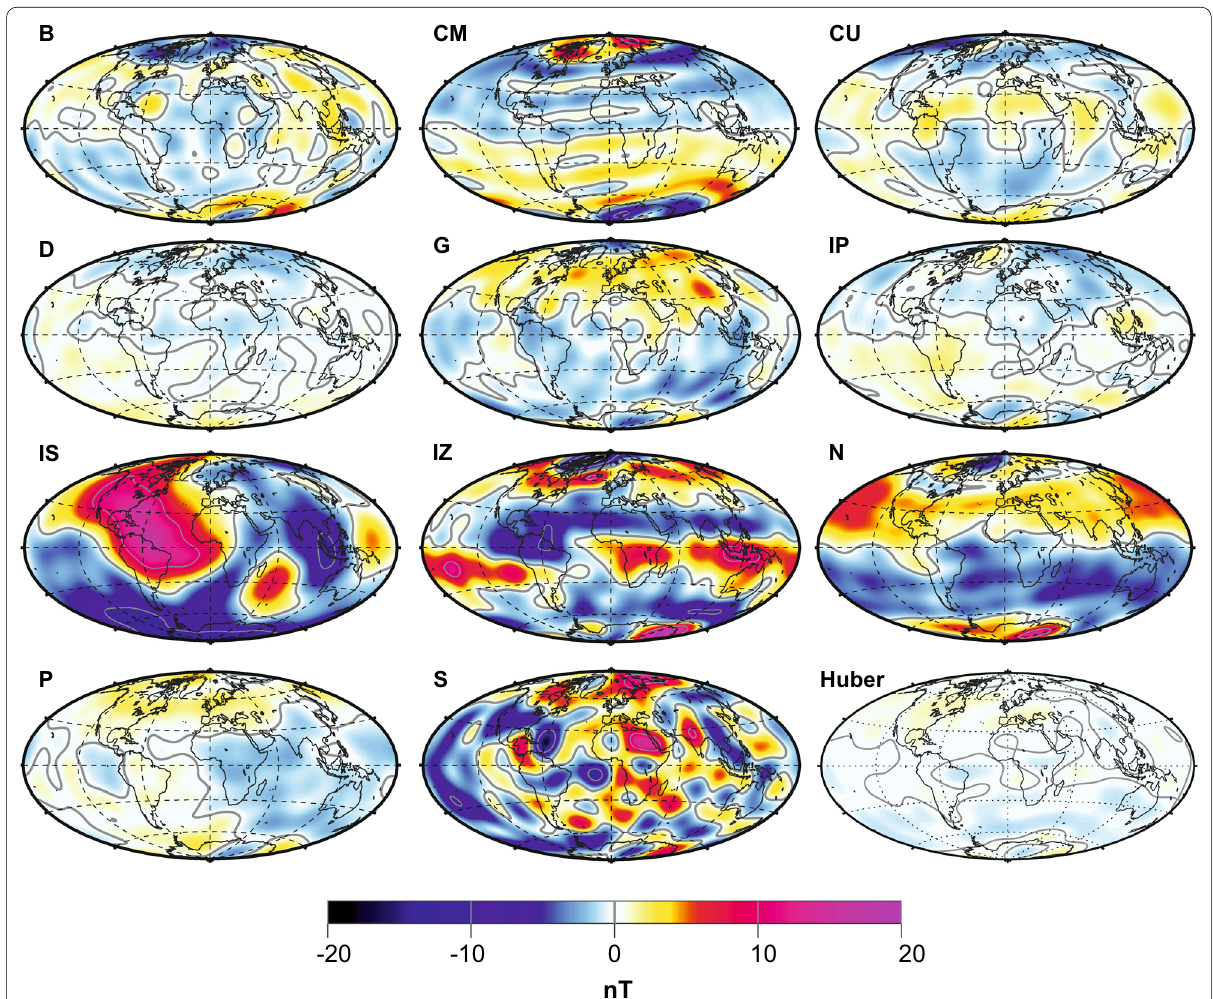
a between the vertical field ( B z ) of the DGRF-2015 candidates and the median model at